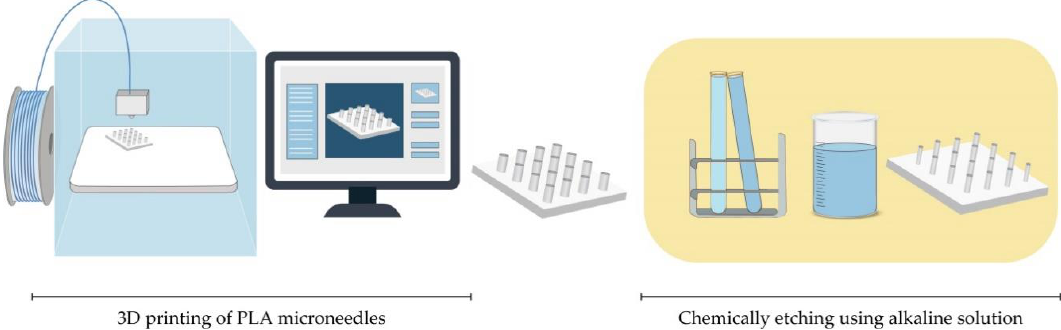
Figure 8. Fabrication of MNs by Fused deposition modelling (FDM) methods, followed by etching in alkaline solution [103,104]. alkaline solution